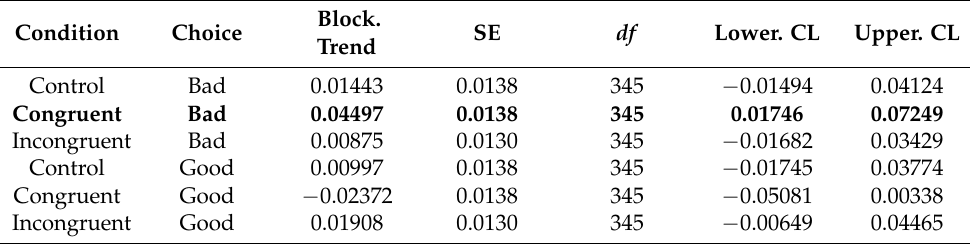
Table 3. Estimates and confidence intervals for the slopes of fixed effects of each Deck × Condition combination. A Kenward–Roger method has been used for degrees of freedom approximation.